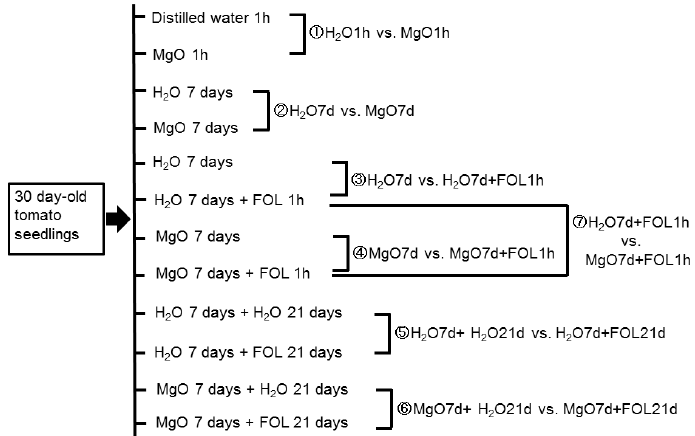
Int. J. Mol. Sci. 2023 , 24 , 2941 Figure 1. Seven comparative groups ( ① ~ ⑦ ) of DEGs. Figure 1. Seven comparative groups ( 1 (cid:13) ~ 7 (cid:13) ) of DEGs.